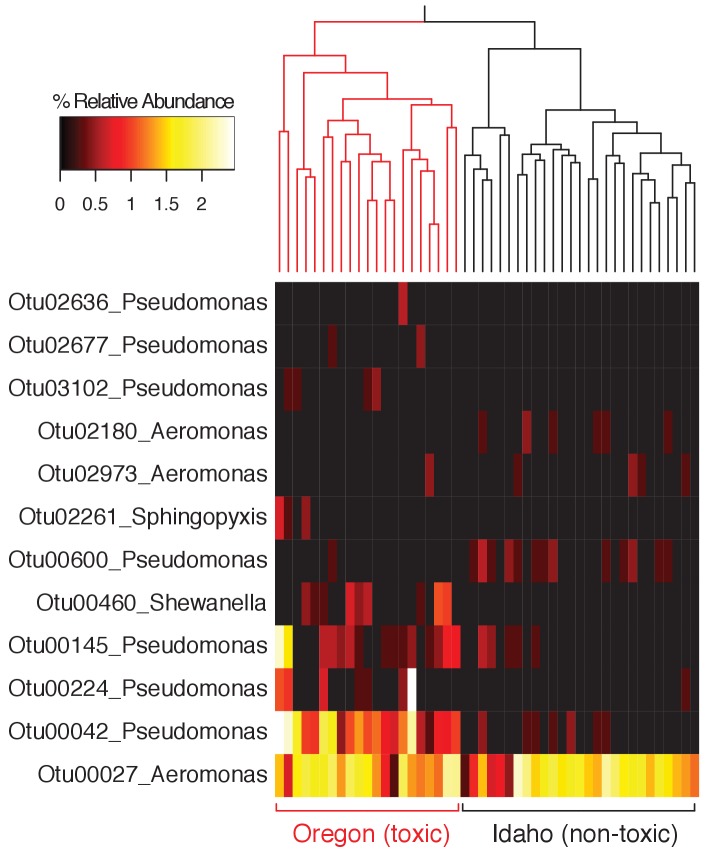
Relative abundance of all OTUs classified to the same genera as TTX-producing bacteria identified in this study (Aeromonas, Pseudomonas, Shewanella, and Sphingopyxis).Skin microbiota samples (dorsal and ventral) are clustered based on Bray-Curtis dissimilarity (Oregon n = 21; Idaho n = 27).